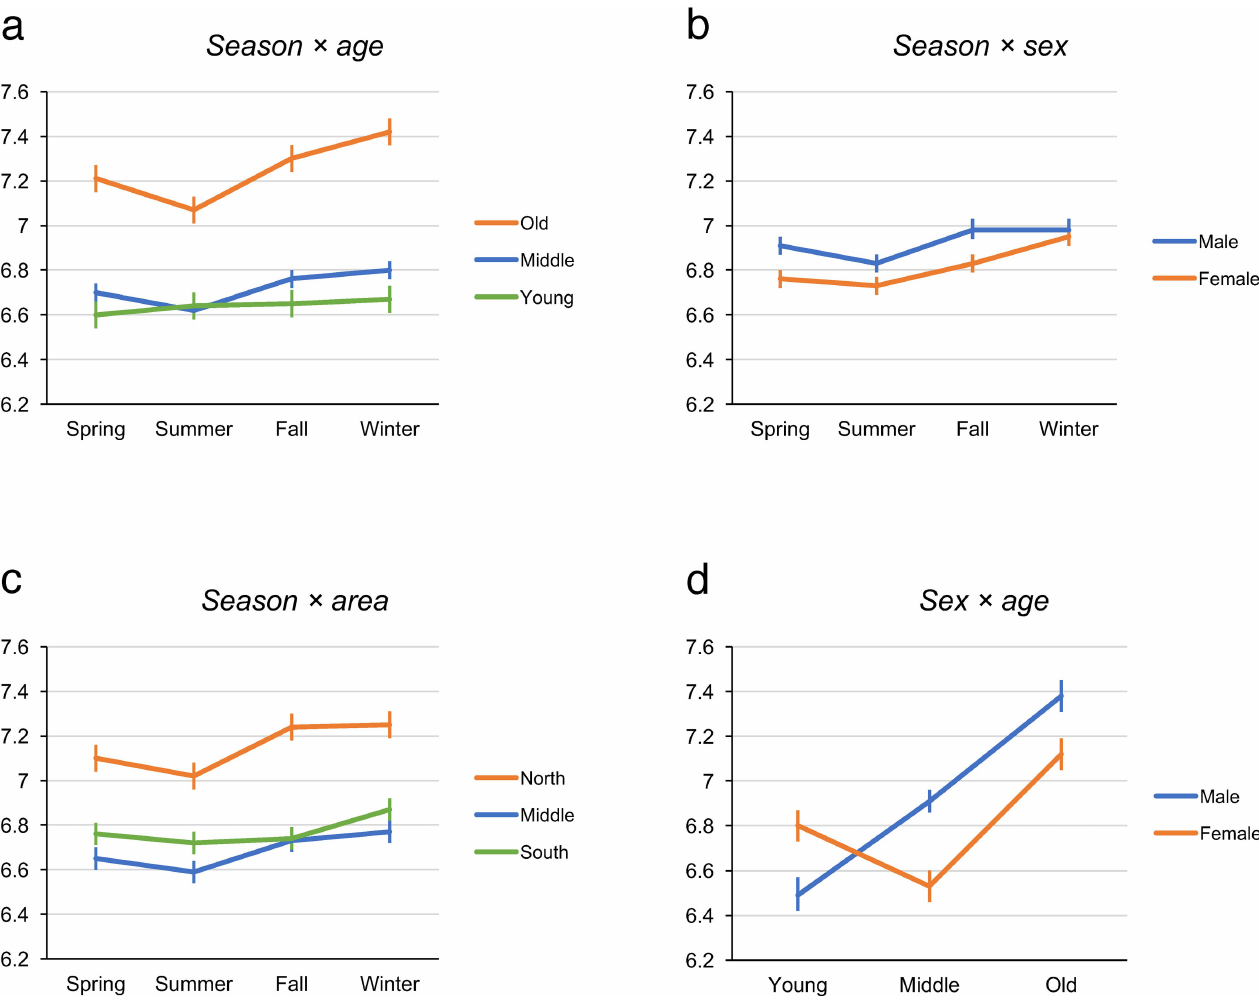
Fig 2. The interactions found in the model: season × age (a), season × sex (b), season × area (c), and sex × age (d). The vertical axis shows the sleep duration (hours). Data are presented as estimated marginal means with standard errors.